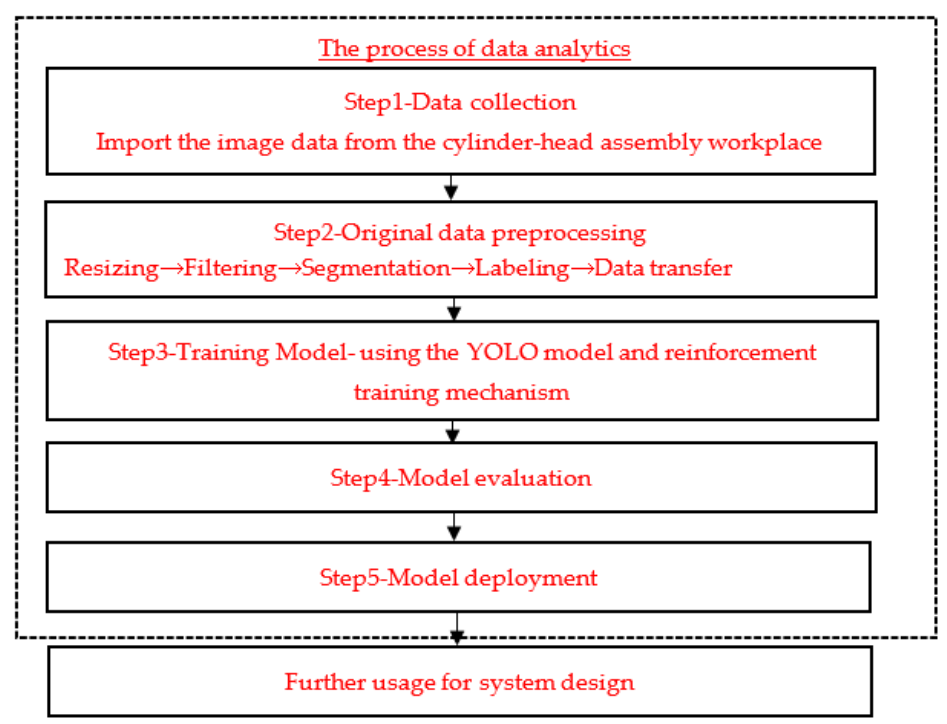
Figure 1. The fl owchart of the data analytics in this study. Figure 1. The flowchart of the data analytics in this study.